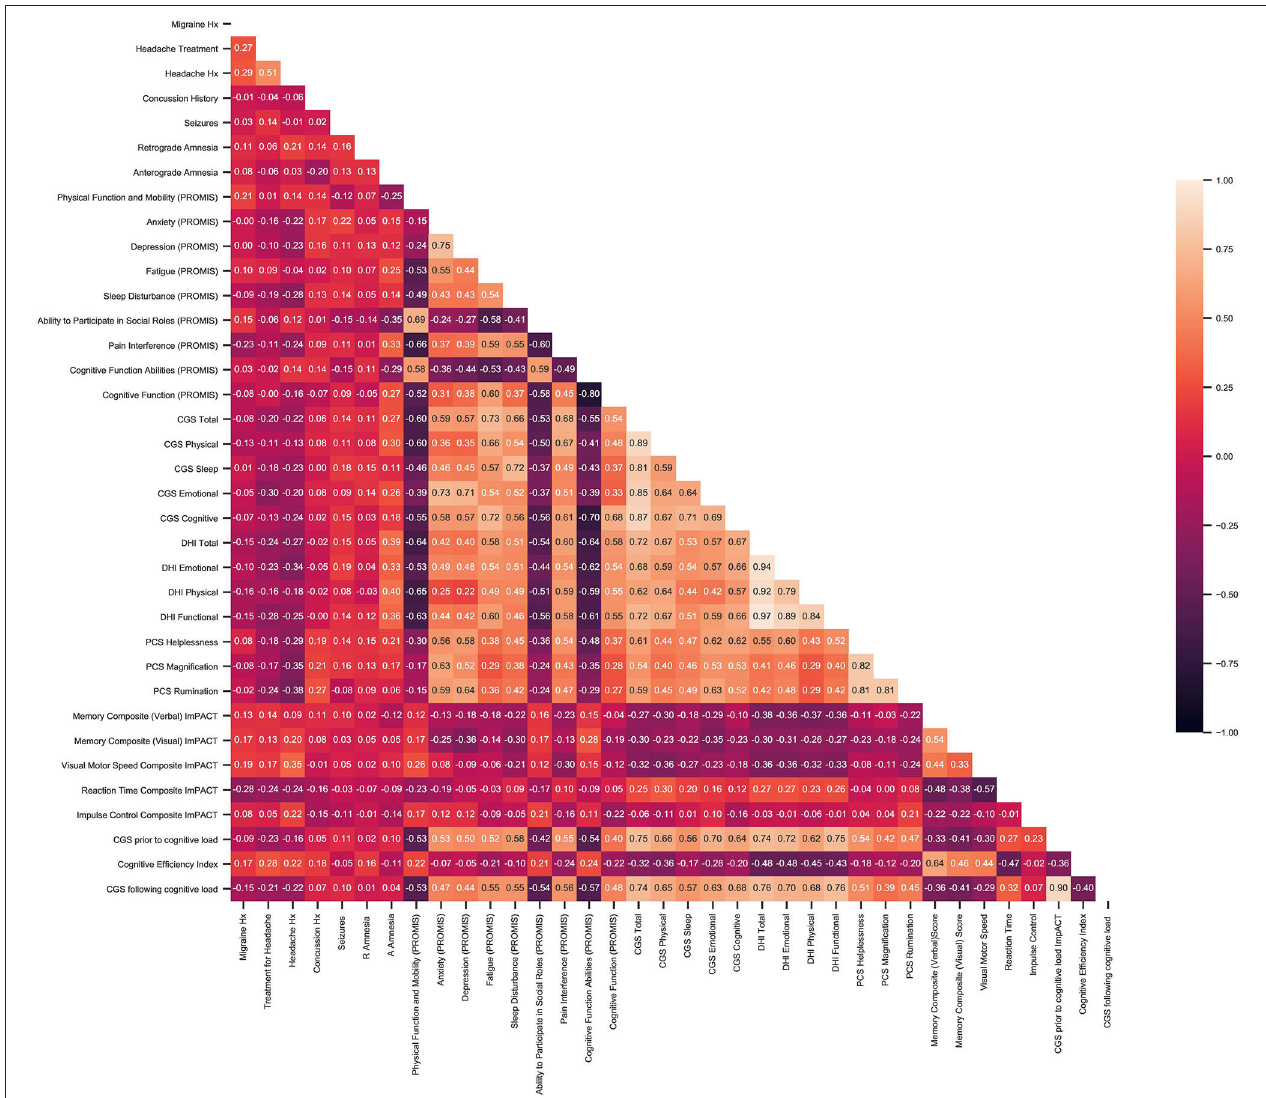
FIGURE 2 | Results of correlation matrix between patient baseline characteristics and objective outcome measures including, PROMIS, CGS DHI, PCS, and ImPACT.